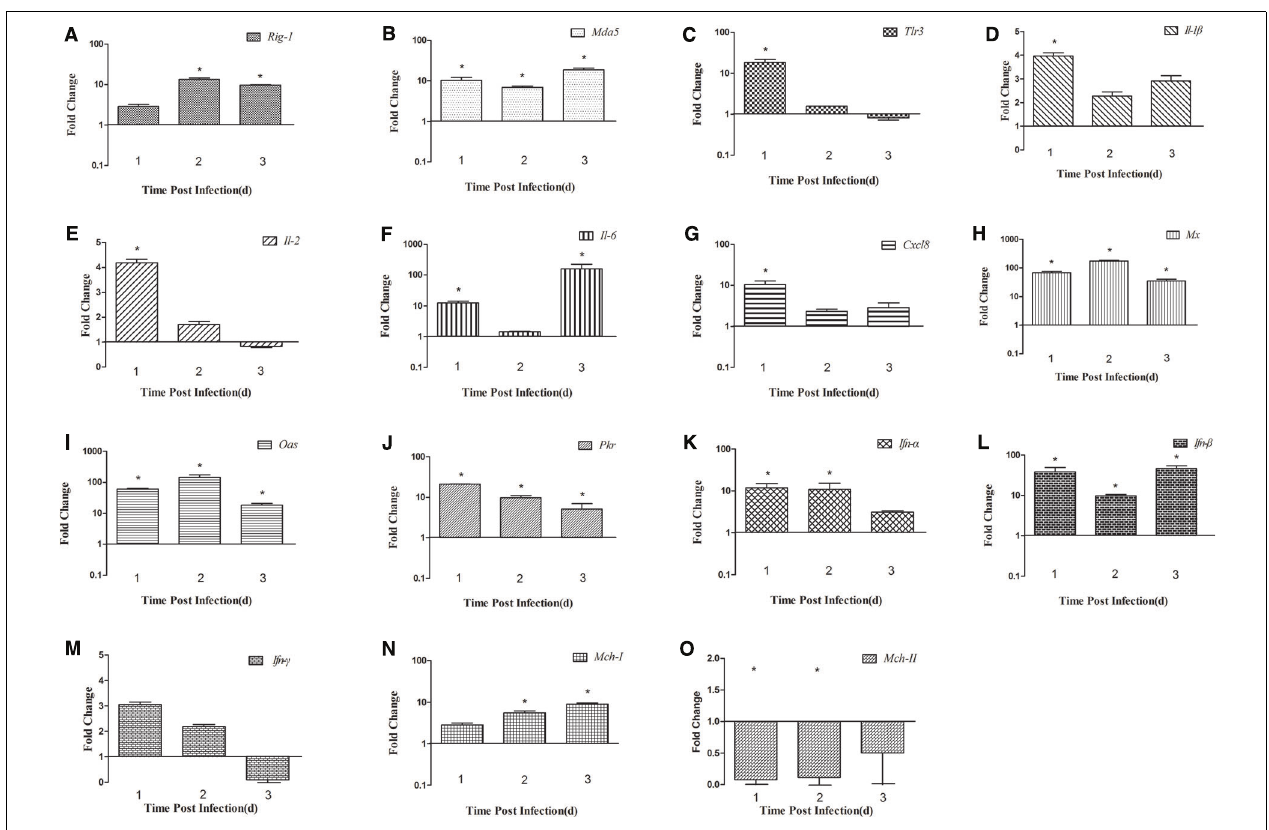
FIGURE 3 | Expression of immune-related genes in the spleens of DTMUV-infected ducks. (A) Rig-1 , (B) Mda5 , (C) Tlr3 , (D) Il-1 b , (E) Il-2 , (F) Il-6 , (G) Cxcl8 , (H) Mx , (I) Oas , (J) Pkr , (K) Ifn- a , (L) Ifn- b , (M) Ifn- g , (N) Mhc-I , and (O) Mhc-II . The Y axis represents the fold change in target